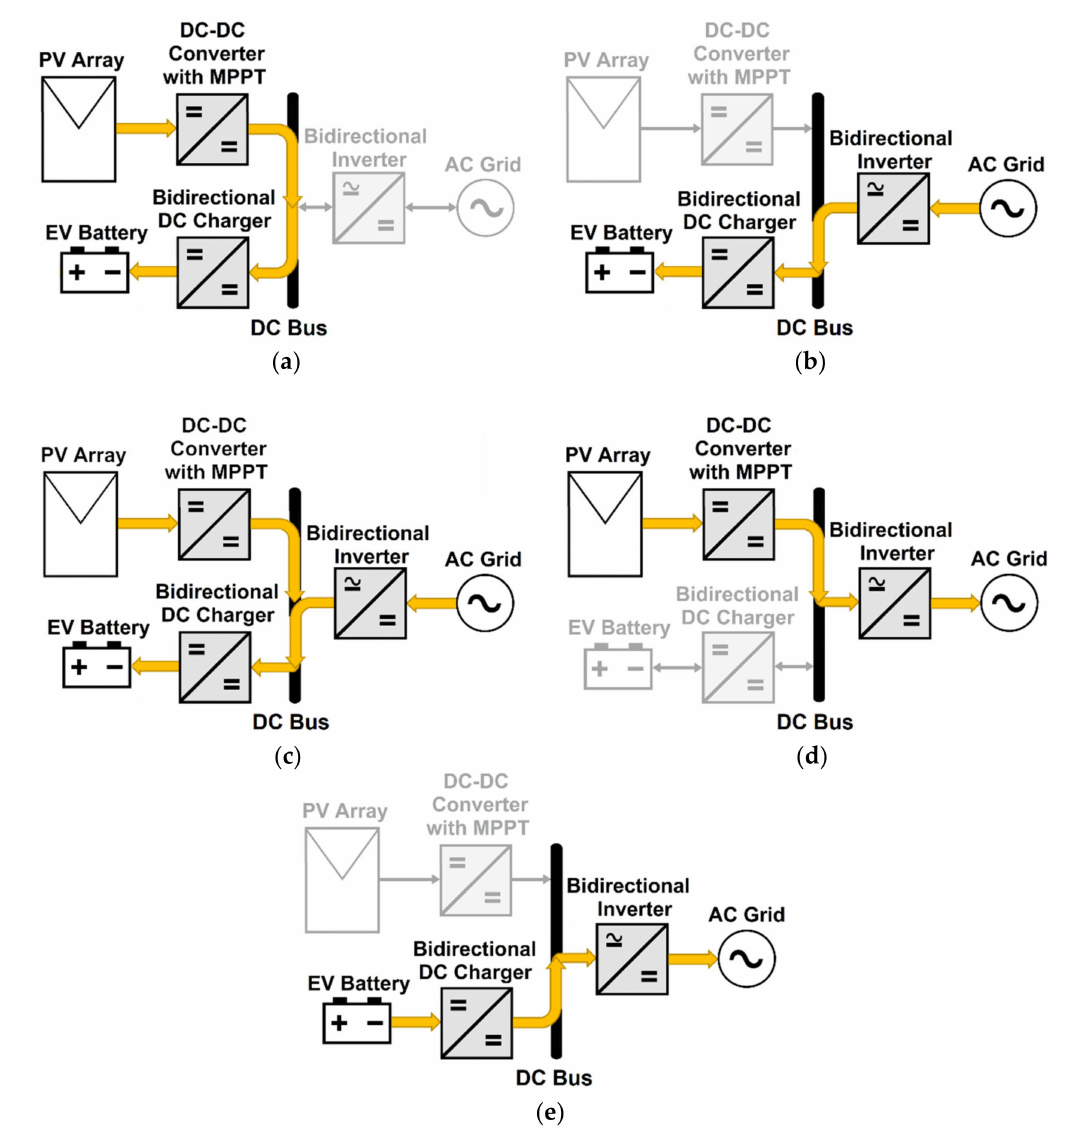
Figure 5. Operating modes for the PV-grid-tied EV charging system. ( a ) PV to battery; ( b ) grid to battery; ( c ) PV and grid to battery; ( d ) PV to grid; ( e ) vehicle-to-grid (V2G)